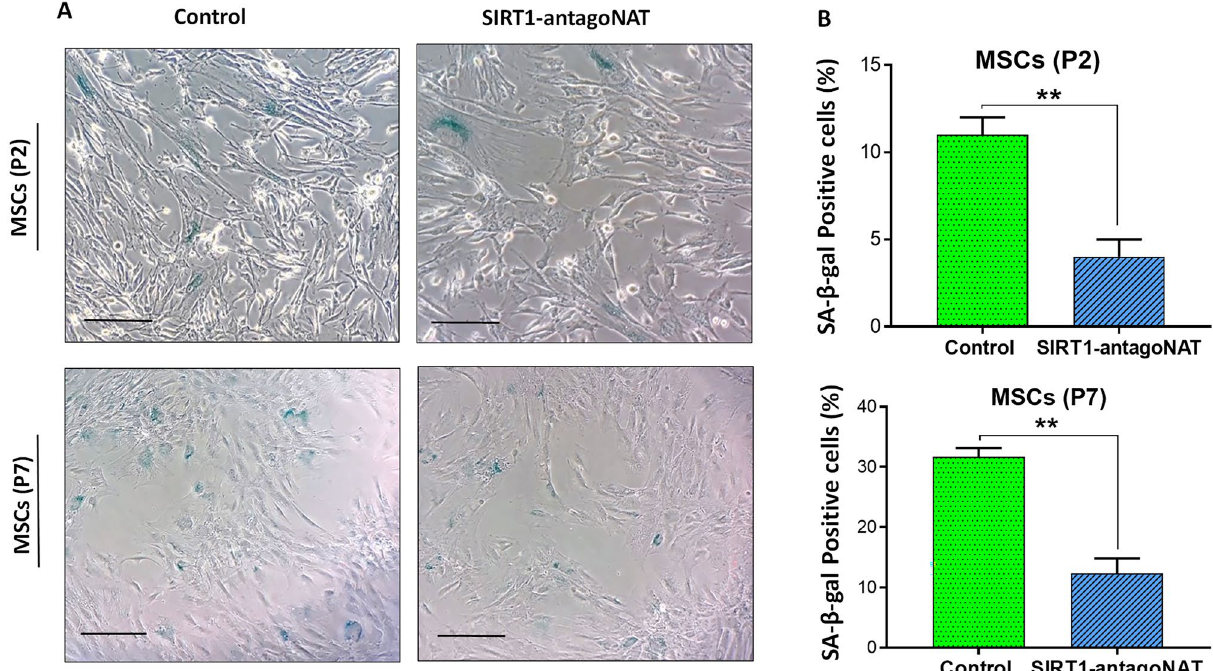
Figure 4. Knockdown of SIRT1-antagoNAT in MSCs reduces the activity of senescence associated β ‐ galactosidase. ( A ) Representative microscopic images from P2 and P7 MSCs transfected with SIRT1- antagoNAT and their controls being stained for senescence associated β ‐ galactosidase (SA-β- gal). ( B ) Bar graphs quantifying the results of SA-β gal staining represented in ( A ). A lower percentage of P2 and P7 MSCs transfected with SIRT1-antagoNAT were SA-β-gal + compared with controls. Scale bars: 100 μm. Data are expressed as mean ± SD (n = 3). ** p <